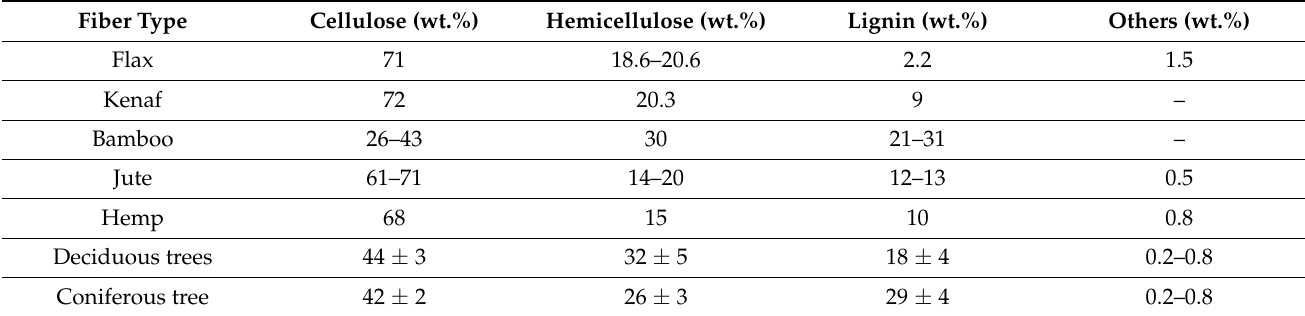
Table 2. Mass content of individual components for plant fibers